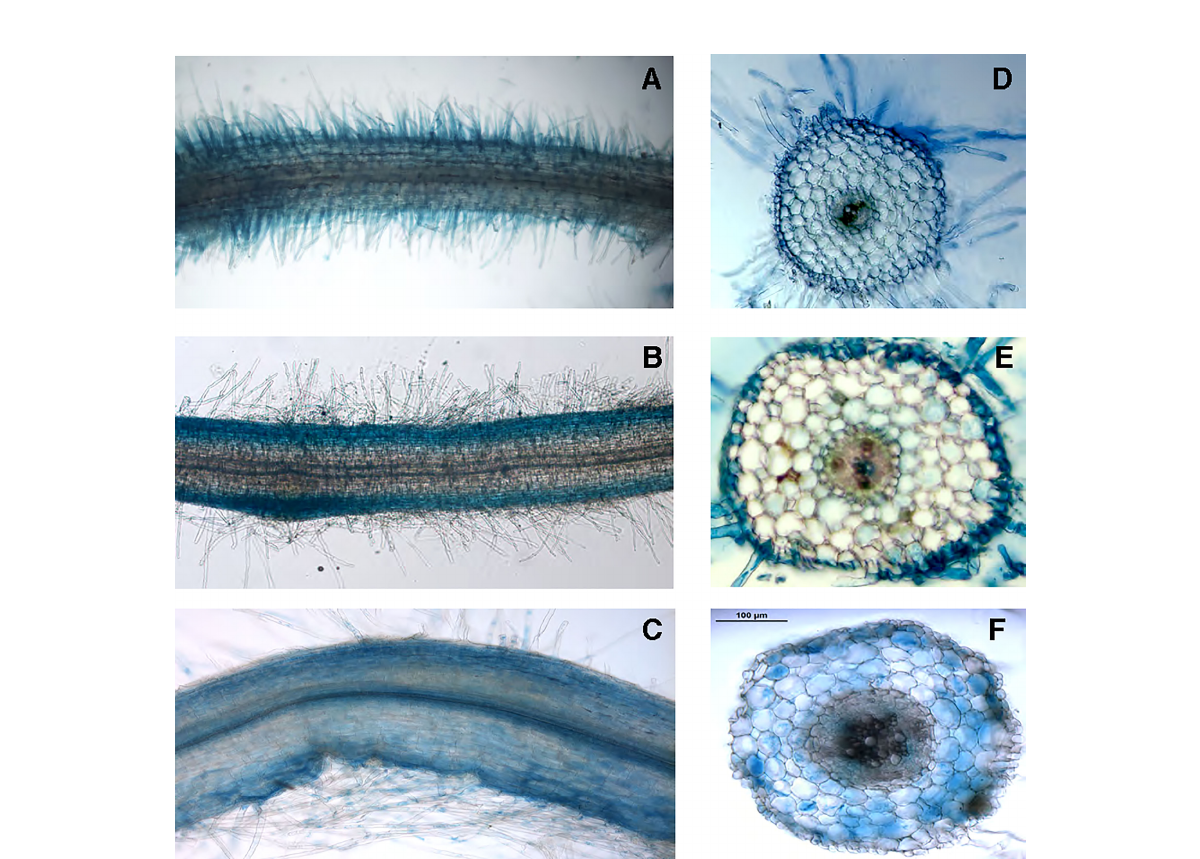
FIGURE 3 Representative GUS activity of L. japonicus transgenic hairy roots transformed with the pr LjNRT2.3 - (A, D) , pr LjNRT2.1 - (B, E) and pr LjNAR2 - gus A (C, F) constructs. (A – C) whole mount root samples. (D – F) 70 m m root cross